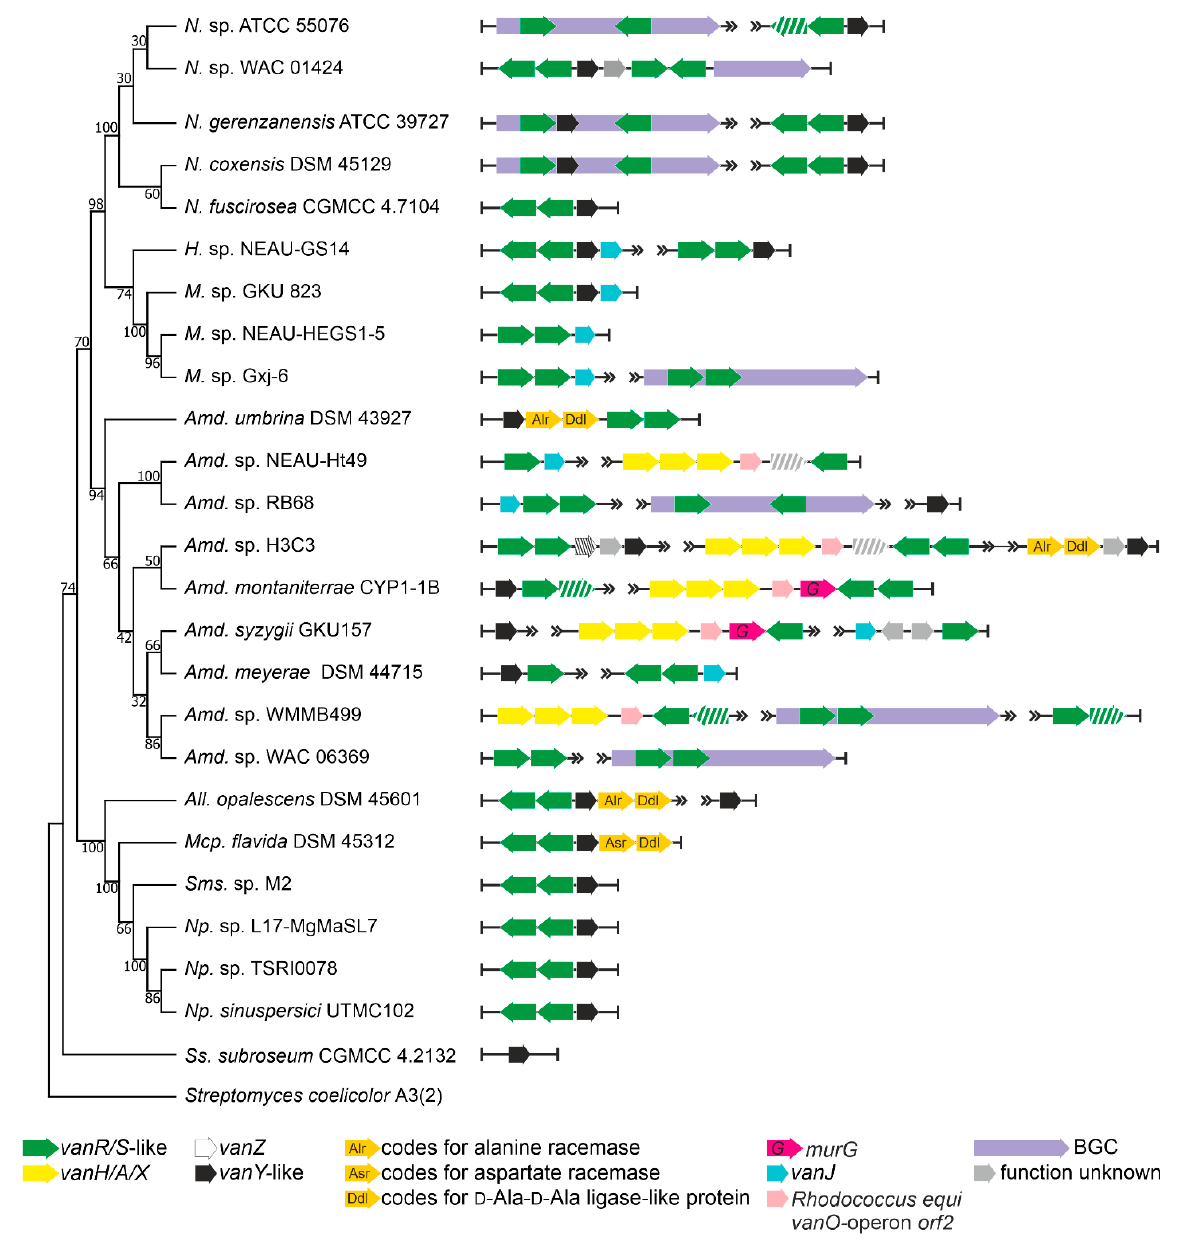
Figure 3. Organization of vlgs found within the set of 25 chosen genomes from Streptosporangiales spp. Maximum Likelihood phylogenetic tree of the 16S rRNA genes of the corresponding species (see Section 4 for details) served as a phylogenetic framework for the scheme. Names of Streptosporangiales genera were abbreviated according to ESM Table S1. The legend below the figure explains the color-coding of the scheme. Please refer to the text for the role of the single genes. Pseudogenes are shaded.